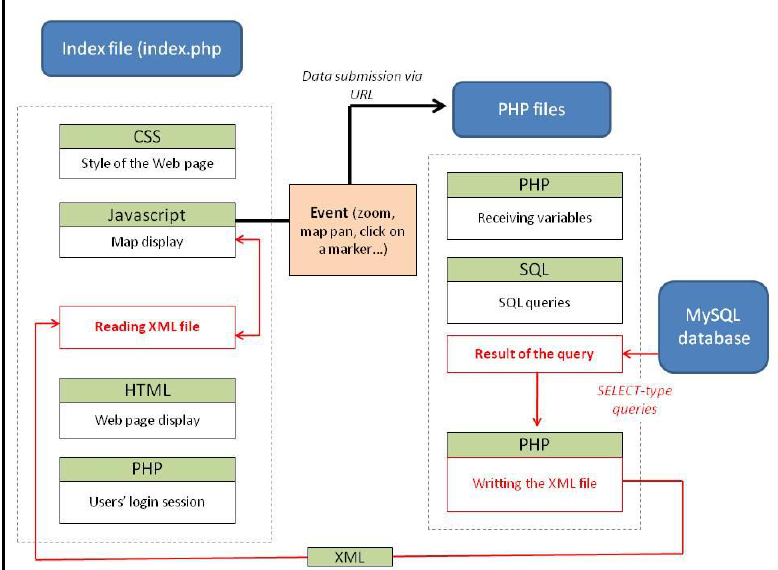
Figure 3. The role of languages in operating the